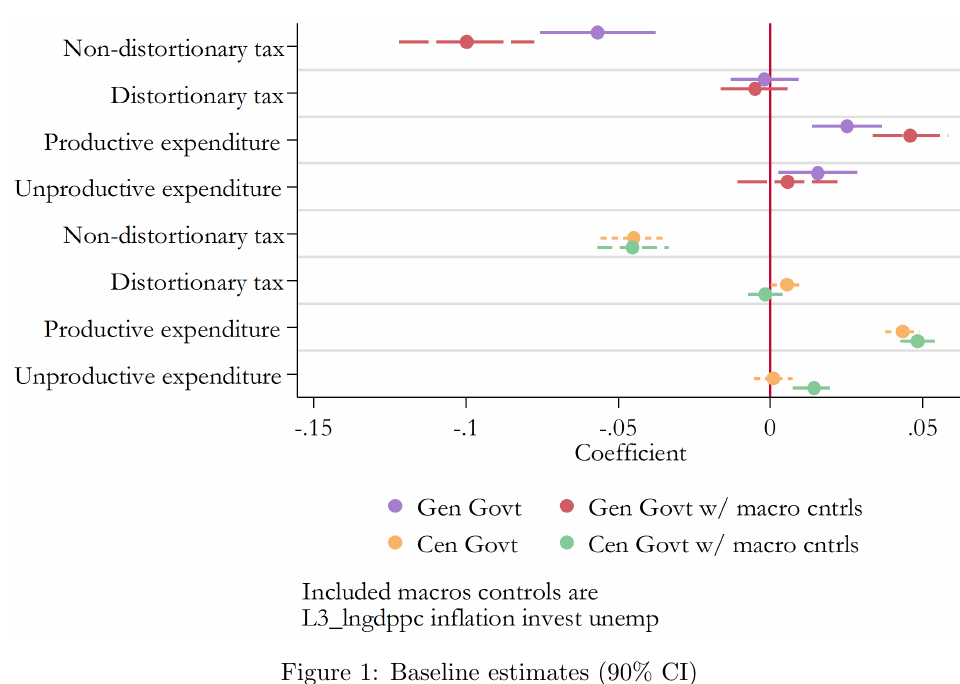
Figure 1: Baseline estimates (90%